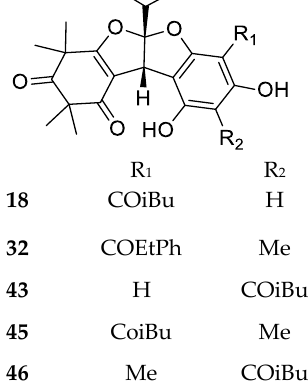
Figure 6. Structures of compounds of the dimeric-bisfurane type.